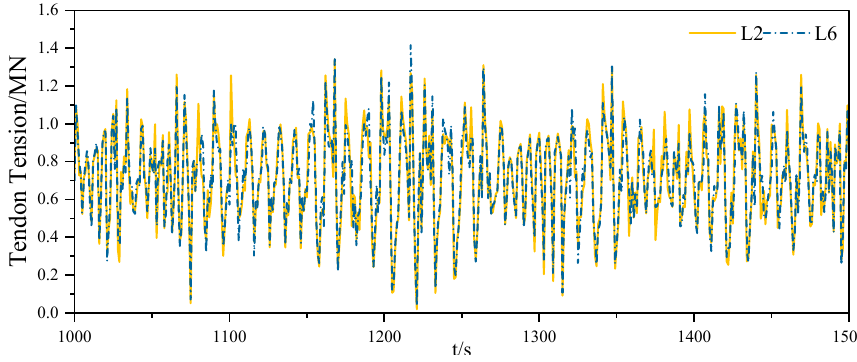
Figure 24. Tendon tension of L2 and L6.